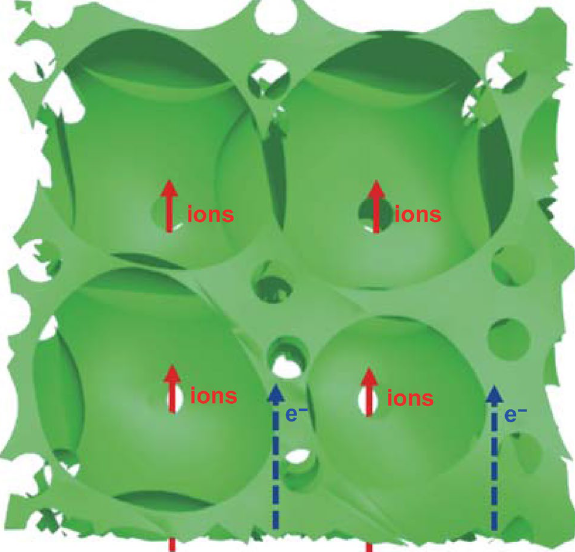
Fig. 4 Schematic of ion transport and electron conduction in 3D EBC